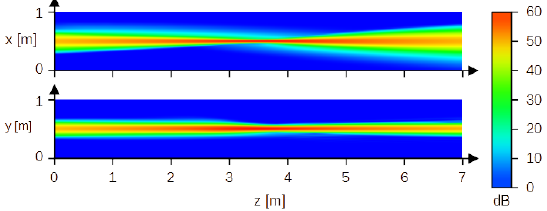
Fig. 9. Horizontal (top) and vertical (bottom) profiles of the U1 beam after the mirror